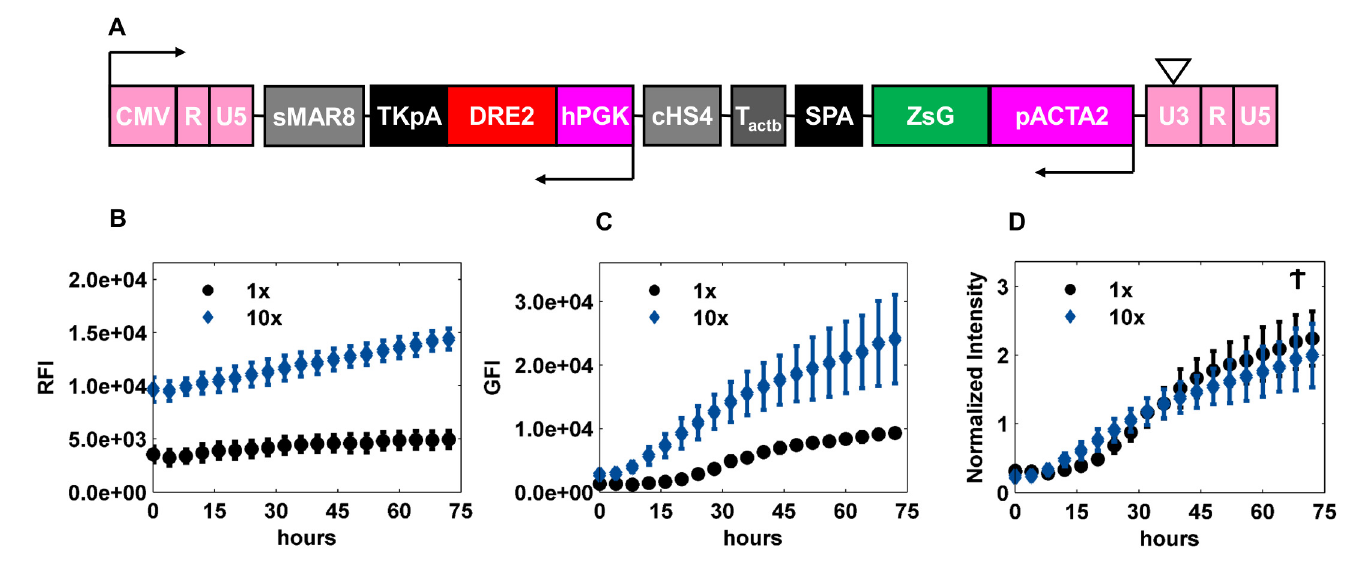
Fig 1. Normalized Promoter Activity is independent of gene copies per cell. (A) Schematic of LVDP-pACTA2-ZsGreen. CMV – promoter sequence from cytomegalovirus; sMAR8 – synthetic MAR sequence 8; TKpA – thymidine kinase polyA from herpes simplex virus; DRE2 – DsRed Express 2; hPGK – human phosphoglycerate kinase promoter; cHS4 – chicken hypersensitive site 4; T actb − a G-rich sequence from the extension of β -actin gene; SPA – synthetic poly A; ZsG – ZsGreen; pACTA2 – α smooth muscle actin promoter; 5 ’ LTR: CMV + R + U5; 3 ’ LTR: U3 + R +U5 (B-D) hBM-MSCs were transduced with LVDP- pACTA2-ZsGreen at two different concentrations that differed by 10-fold (1X and 10X). Both red and green fluorescence intensity were measured upon induction to myogenic differentiation. (B) Red Fluorescence Intensity (RFI), (C) Green Fluorescence Intensity (GFI), and (D) Normalized Intensity were plotted against time. Normalized intensity was obtained by dividing GFI by a weighted average of RFI over time, where the weights were determined from a beta distribution (see Materials and Methods) such that the median absolute standard deviation was minimized from the LOESS fit. Data shown are representative of at least three experiments performed with similar results. Ϯ p-value > 0.05.